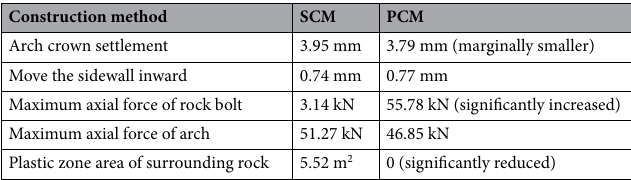
Table 9. Comparison of two construction methods.